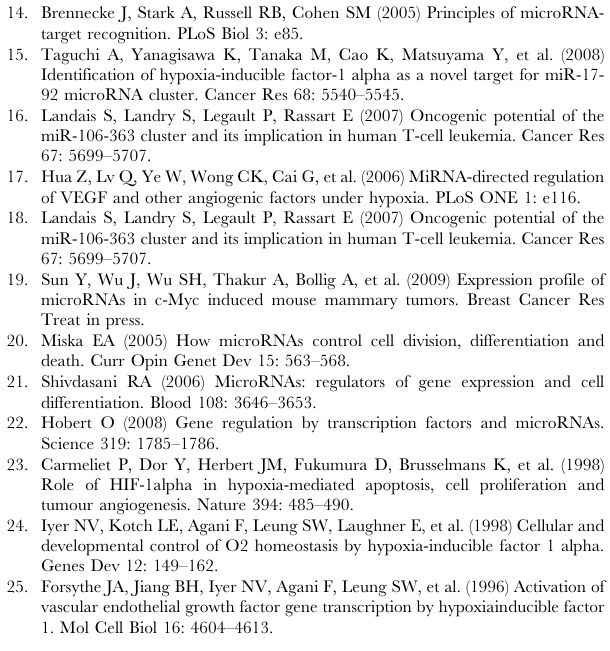
Figure S2 The expressions of miR-20a, 106a, 18b, 92-2 and 363 are not affected by different oxygen concentrations. The H22 and B16 tumor cell lines were treated with different oxygen concentrations. The expressions of microRNAs were detected by real time RT-PCR. The expression level in the hypoxia groups was designated as 1. Figure S3 HIF-1 a is expressed in the central H22 tumor tissues but not in marginal tumor tissues. H22 tumor cells were subcutaneously injected to the left flank of BALB/c mice. When the tumor size reached 9 6 9 mm, central or marginal tumor tissues were surgically excised for the preparation of sections. The sections were used for immunohistochemical staining against HIF- 1 a . (A) The central tumor tissue was positively stained. (B) The marginal tumor tissue was negatively stained. (C) The interface of negative (marginal) and positive (central) staining of HIF-1 a . Found at: doi:10.1371/journal.pone.0007629.s003 (2.19 MB TIF) Figure S4 Stem-loop structure of reverse transcription primers for miR-199b, 18a, 20b and 155. The primers were designed with RNA mfold version 2.3 server. The 3 9 -end sequences of TAACCAA, CTATCTG, CTACCTG and ACCCCTA were complementary to the 3 9 -end sequence of miR-199b, 18a, 20b and 155,